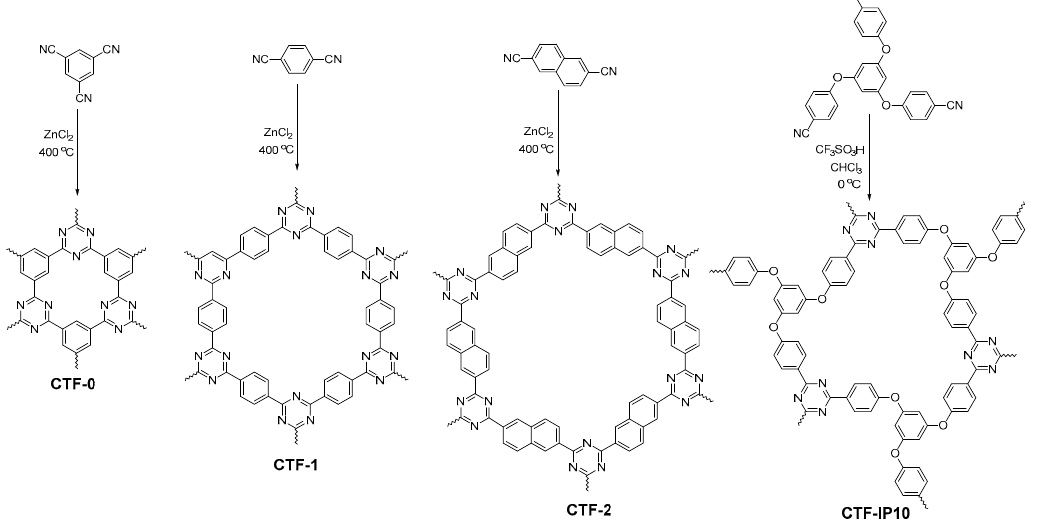
Figure 24. Construction of crystalline covalent triazine frameworks by self-condensation of aromatic nitriles. Some CTFs were prepared in molten ZnCl 2 at high reaction temperatures (400 °C~700 °C). Yet